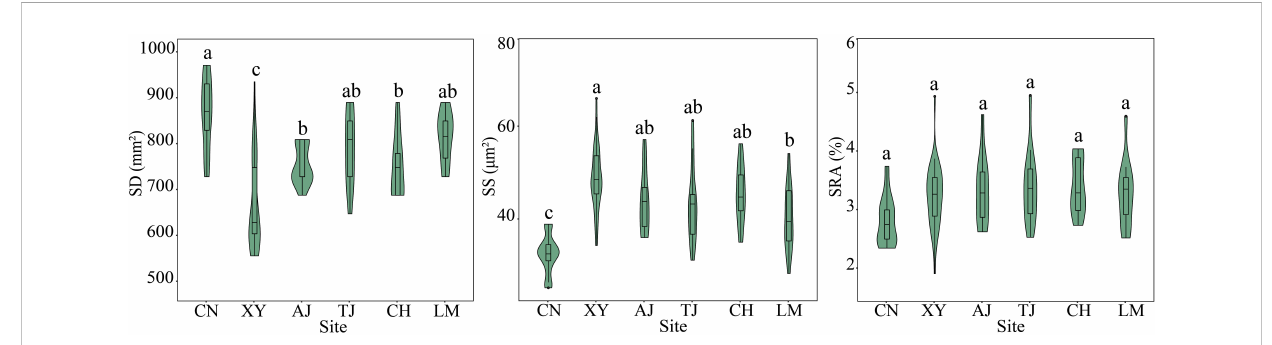
FIGURE 3 Leaf stomatal traits of moso bamboo forests in different sites. AJ, Anji; CH, Conghua; CN, Changning; LM, Longmen; TJ, Taojiang; XY, Xinyang. Different letters indicate signi fi cant differences among sites at the 0.05